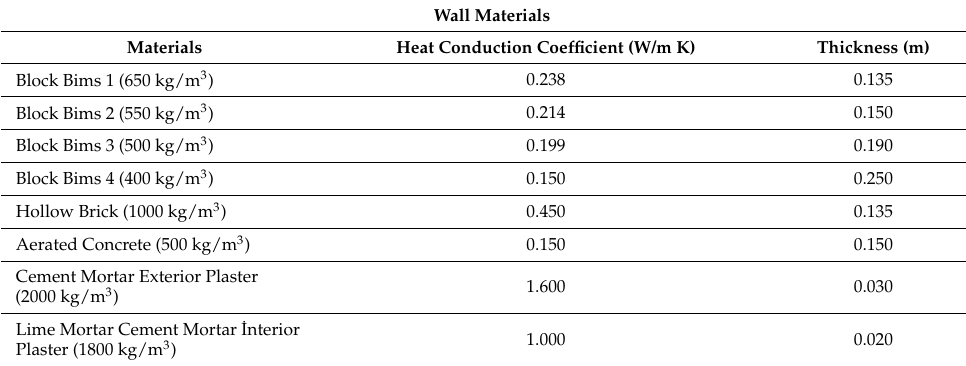
Table 4. The properties of wall materials [15,31].